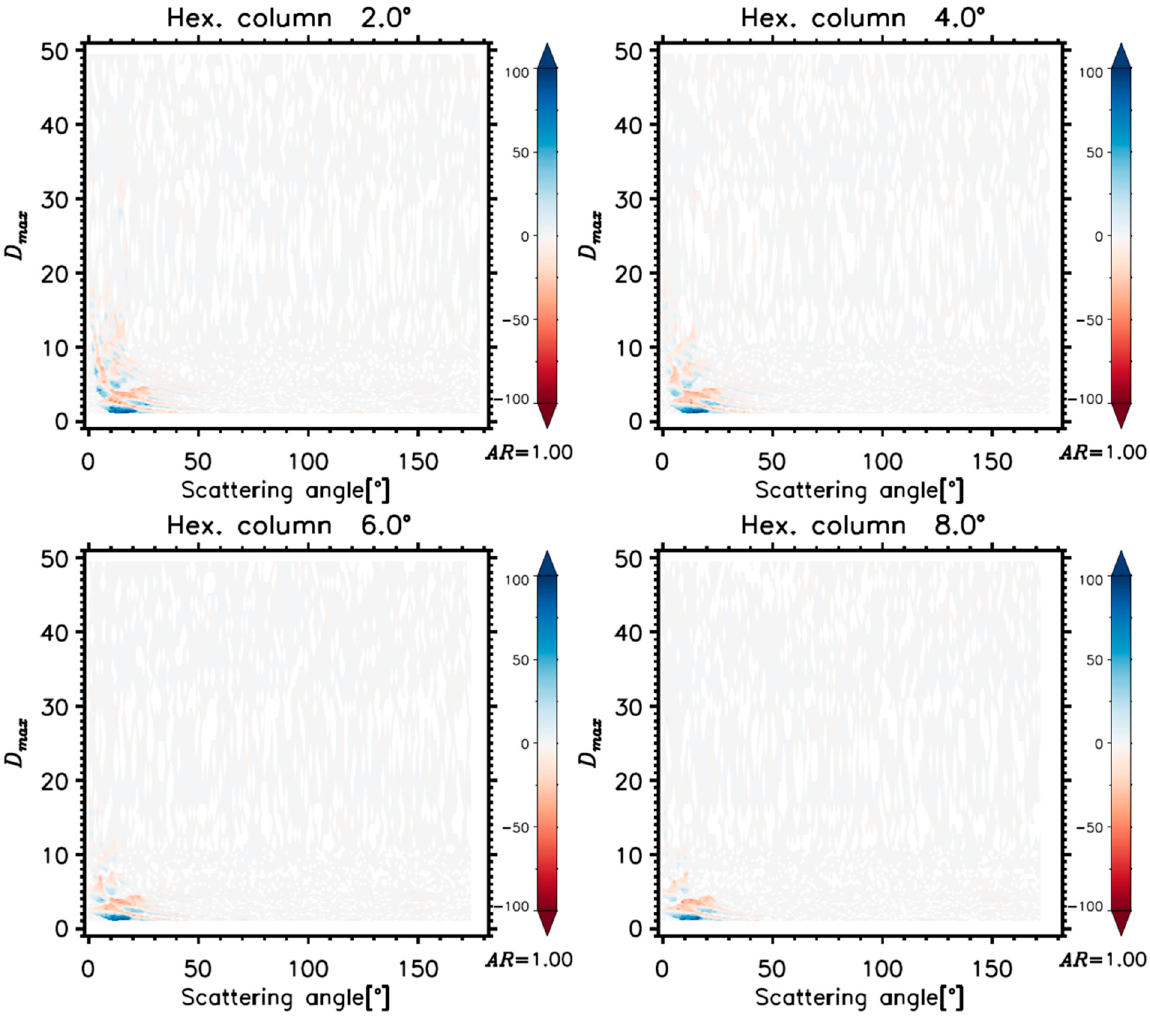
Figure 17. Determined sizing errors (%) as functions of scattering angles and the size ( D max ) of hexagonal ice crystals with AR = 1.00 only using the ADDA. Different panels indicate different resolutions (i.e., 2°, 4°, 6°, and 8°) of scattering angles.